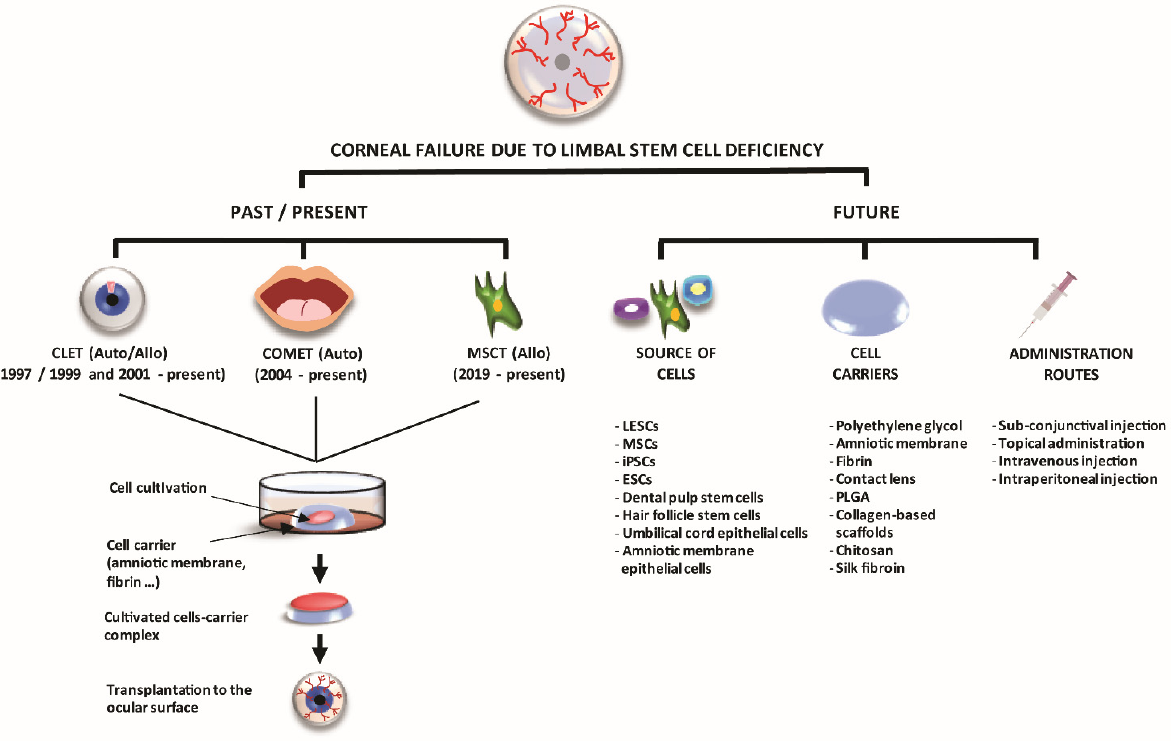
Figure 6. Representation of the different stem cell-based therapy techniques, sources of cells, cell carriers, and alternative administration routes that were used in the past, are being used at present, or will likely be used in the future. Auto: autologous; Allo: allogeneic; CLET: cultivated limbal epithelial transplantation; COMET: cultivated oral mucosa epithelial cells; ESCs: embryonic stem cells; iPSCs: induced pluripotent stem cells; LESCs: limbal epithelial stem cells; LSCD: limbal stem cell deficiency; MSCs: mesenchymal stem cells; MSCT: mesenchymal stem cell transplantation; PLGA: poly lactide-co-glycolic acid.